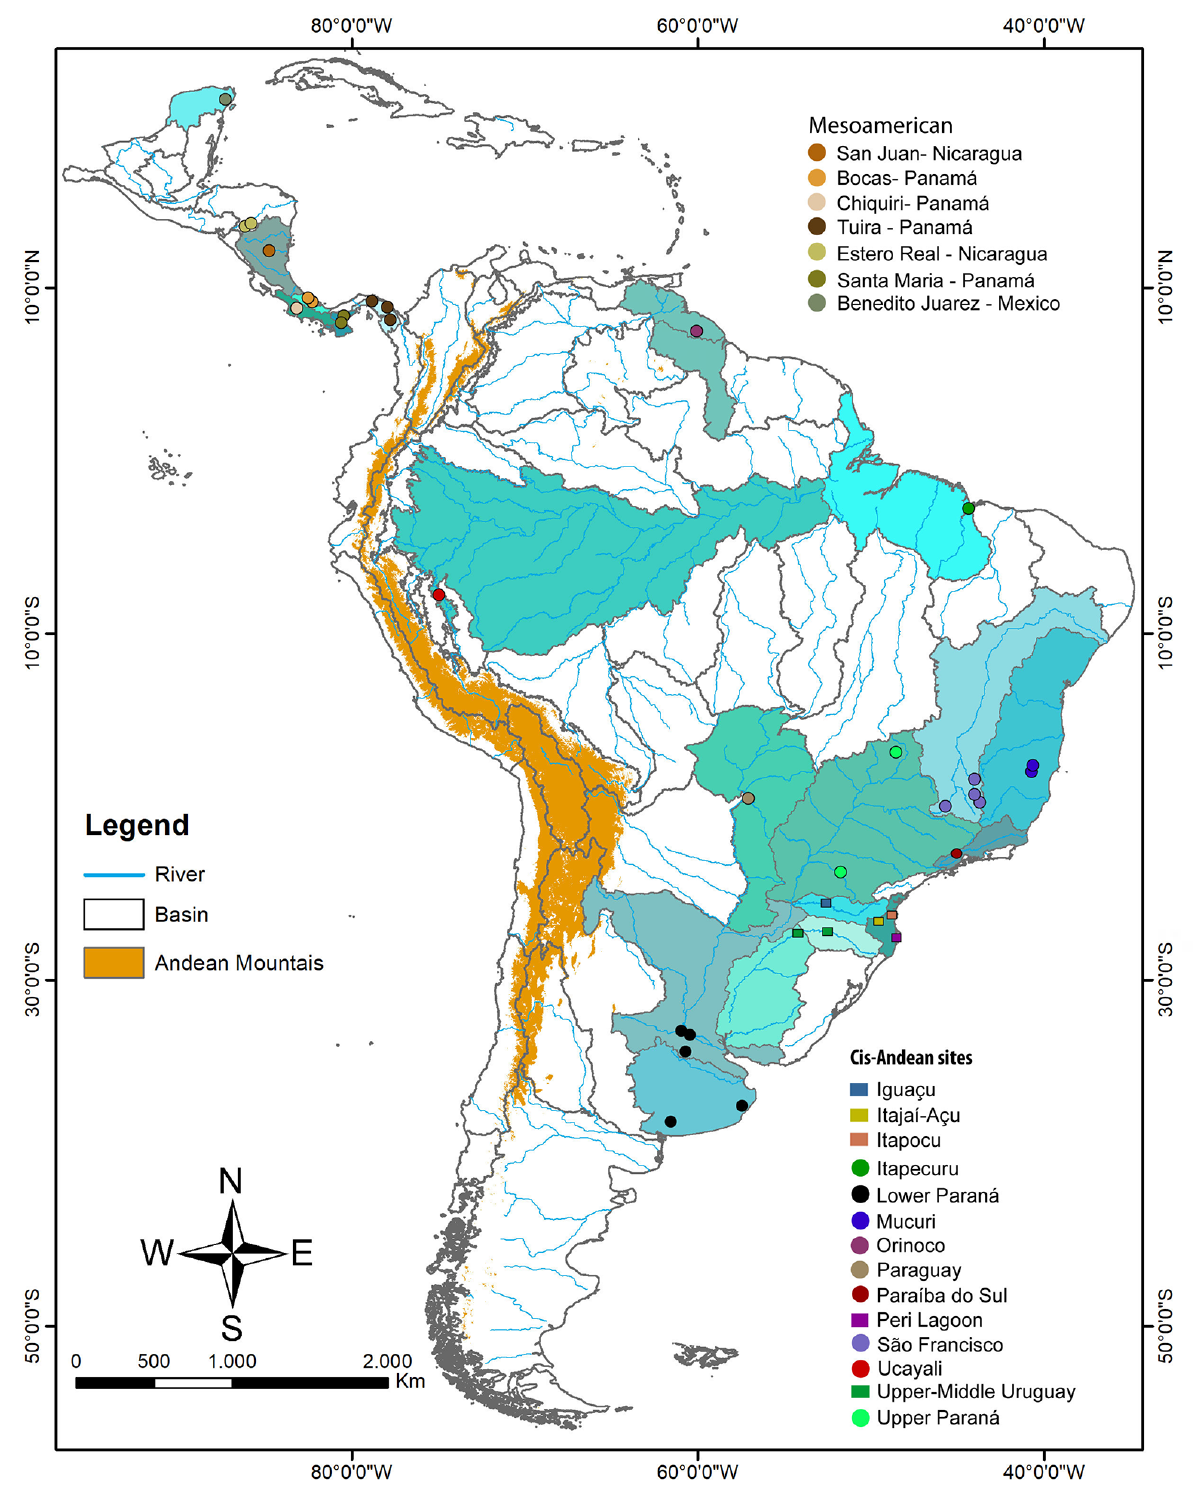
Figure 1 – Sampling sites of Rhamdia species in South America. Circles represent samples from BOLD System (http://www.boldsystems.org/), while squares are sequences obtained in this study. Colors indicated the hydrographic basin where